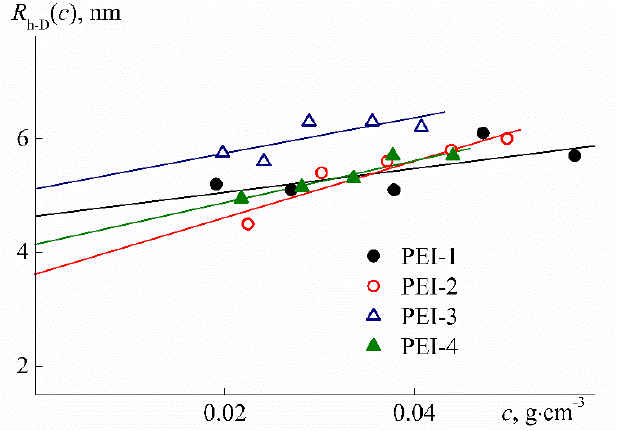
Figure 5. Concentration dependencies of hydrodynamic radius R h-D ( c ) for solutions of PEI-n in chloroform. Polymers 2020 , 12 , x FOR PEER REVIEW